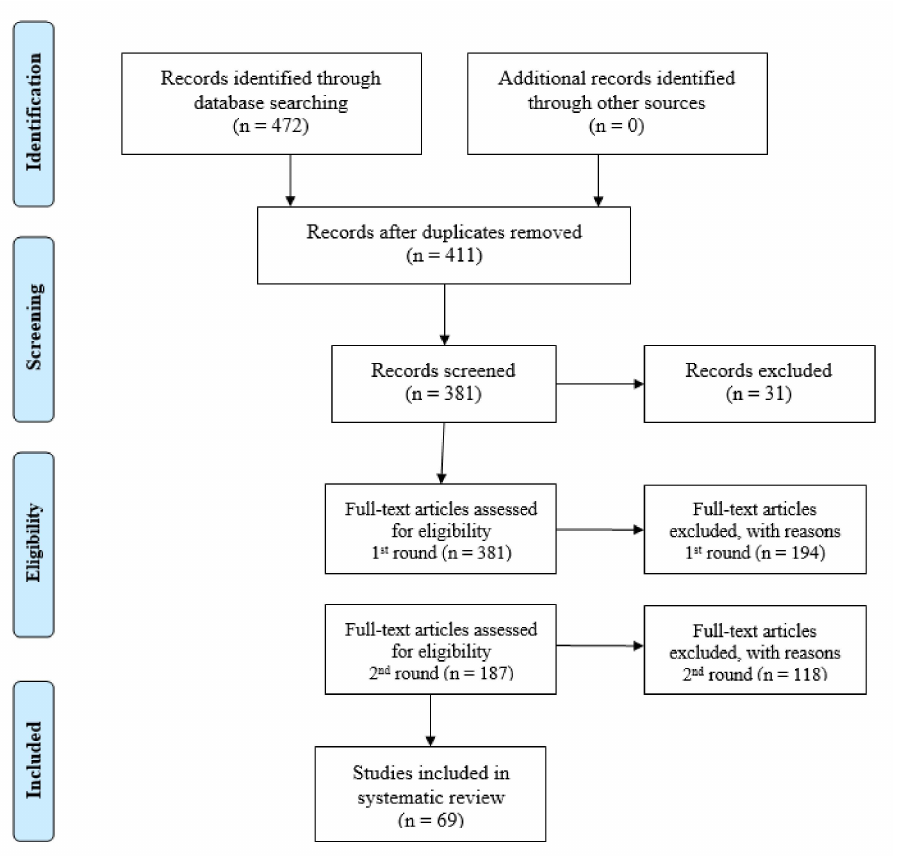
Figure 4. The PRISMA